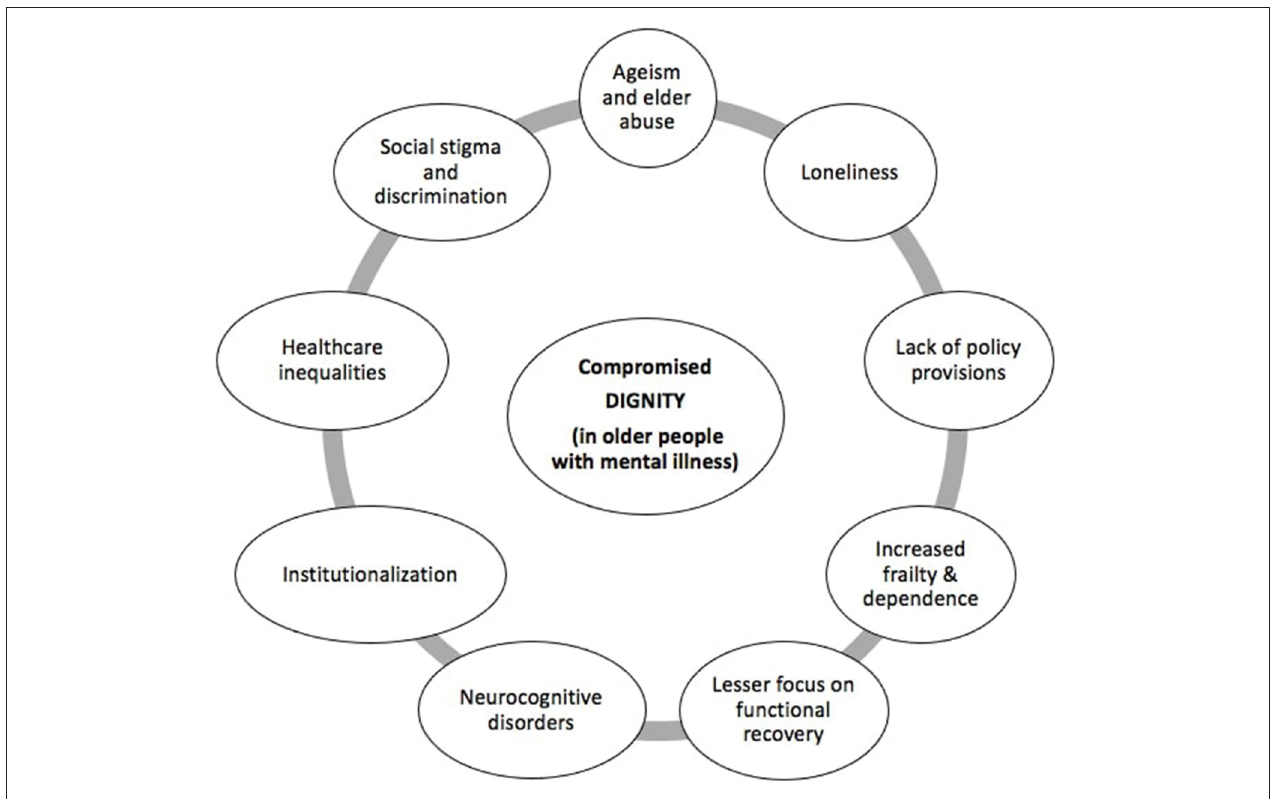
FIGURE 1 | Various factors that impose threat to dignity in older people living with mental